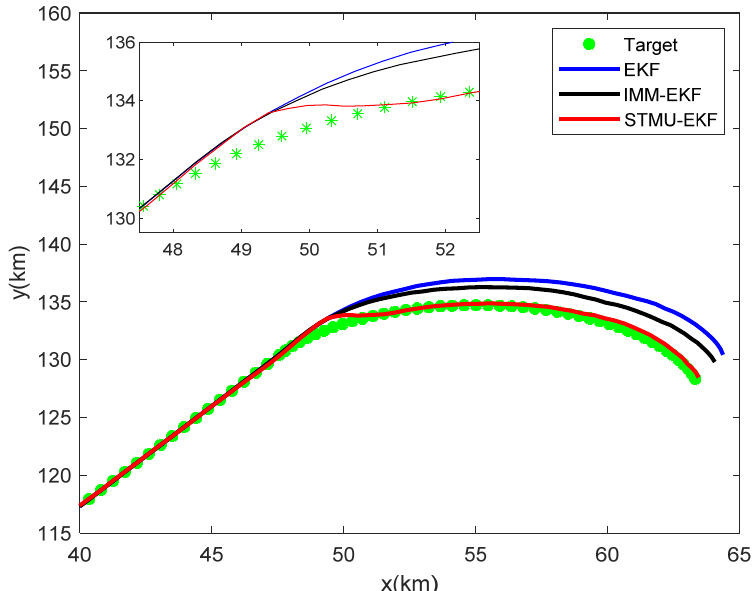
Figure 5. The target tracking trace of the three passive target tracking algorithms.